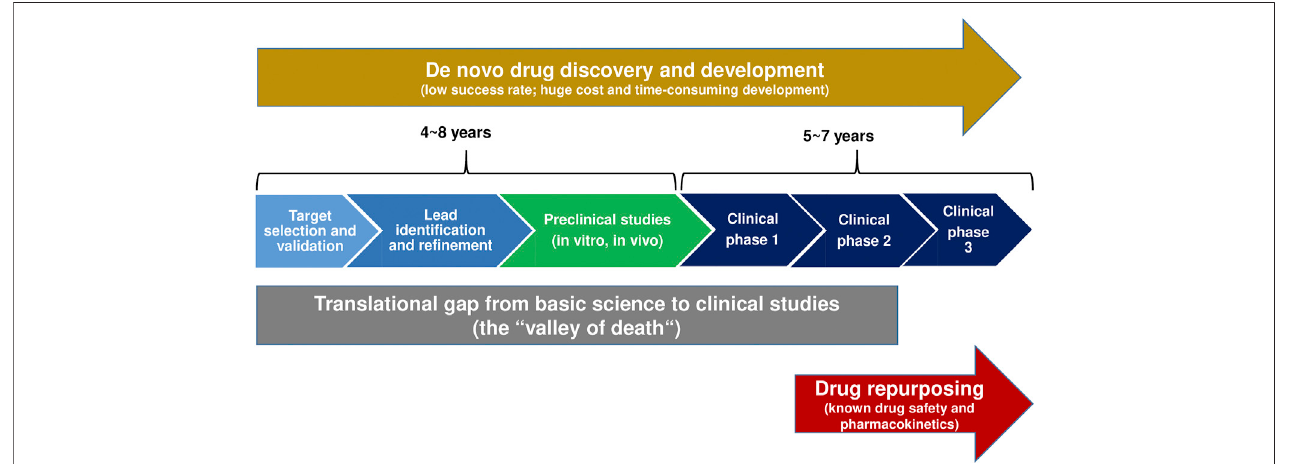
FIGURE 1 | A comparison of traditional de novo drug discovery and development versus drug repurposing. The translation gap ( “ valley of death ” ) describes the problem of translation of basic scienti fi c fi ndings in a laboratory setting into human applications and potential treatments (Butler, 2008; Gamo et al., 2017). Drug repurposing reduces this gap and thus the time, risk, and investment associated with the development of new therapies.